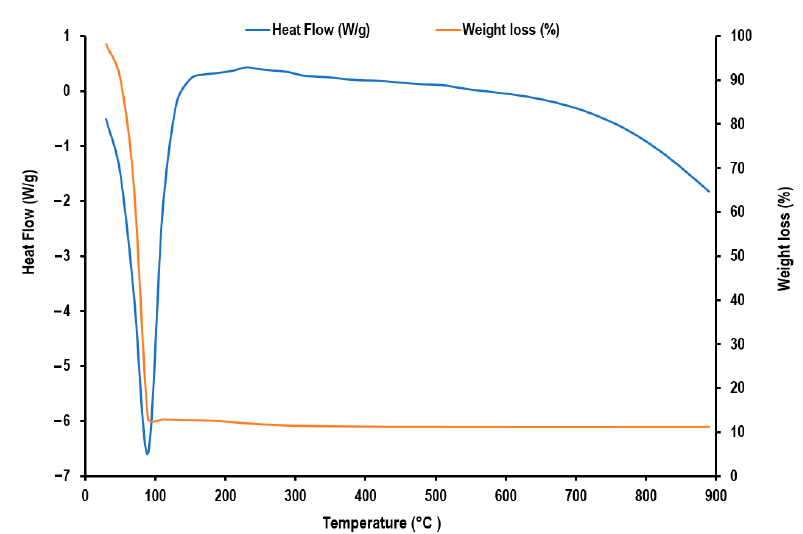
Figure 12. Heat flow (W/g) and weight loss (%) of A-IONPs sample.